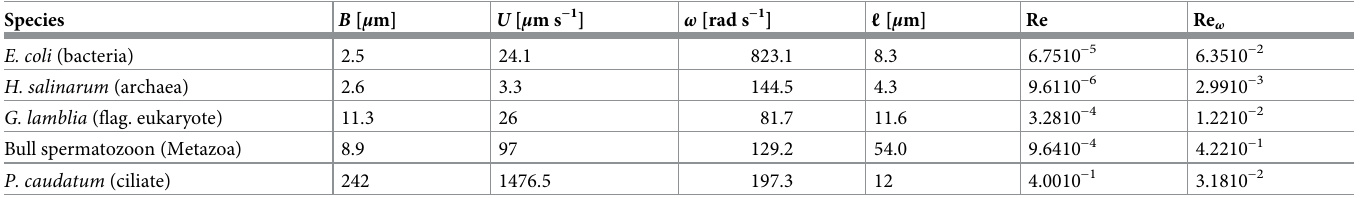
Table 1. Steady (Re) and oscillatory (Re ω ) Reynolds numbers for five representative organisms from the database. The values of the mass density ( ρ ) and dynamic vis- cosity ( η ) used correspond to water at 25˚C. Species